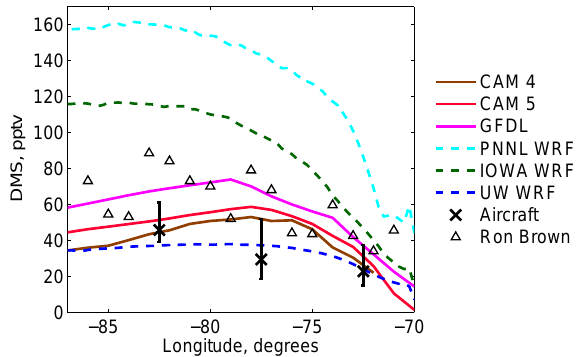
Figure 8. MBL-mean DMS concentrations (inpptv) along 20 ◦ S for some models along with C-130-observed MBL means marked by “X”. Near-surface means from the R/V Ron Brown measurements (M. Yang et al., 2011) are marked by